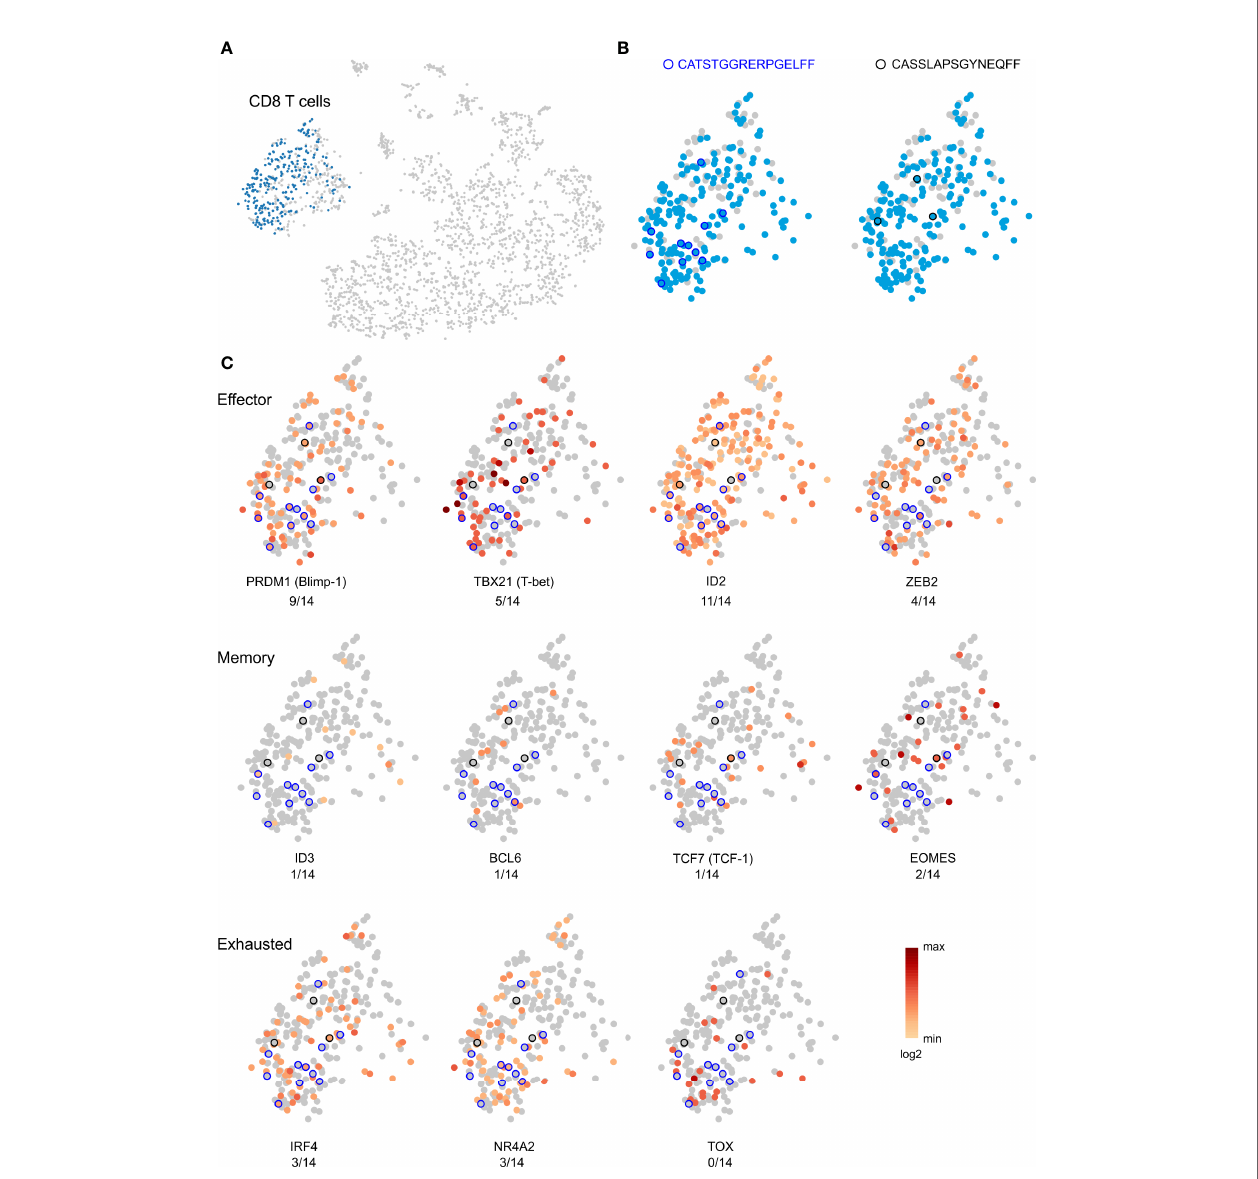
FIGURE 5 | Effector phenotype of public and private TCR clonotypes. (A) t-SNE plot, based on single cell RNA expression data, of brain-in fi ltrating leukocytes from Patient 595 ’ s second surgery. CD8 T cells are colored blue. (B) Location within the cluster of T cells of the two clonotypes that overlap between the post-surgery blood and brain ( Figure 4 ). Clonotypes are circled in black. (C) Single cell heat maps for transcription factors that de fi ne effector, memory, and exhausted CD8 T cells. Of the 11 T cells that express the two TCRs, the majority of the cells likely correspond to effector T